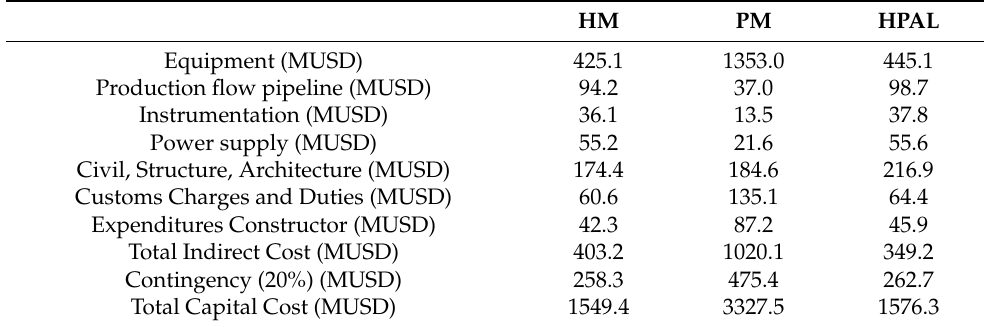
Table 6. Summary of the main items of capital expenditures for three technologies (HM—